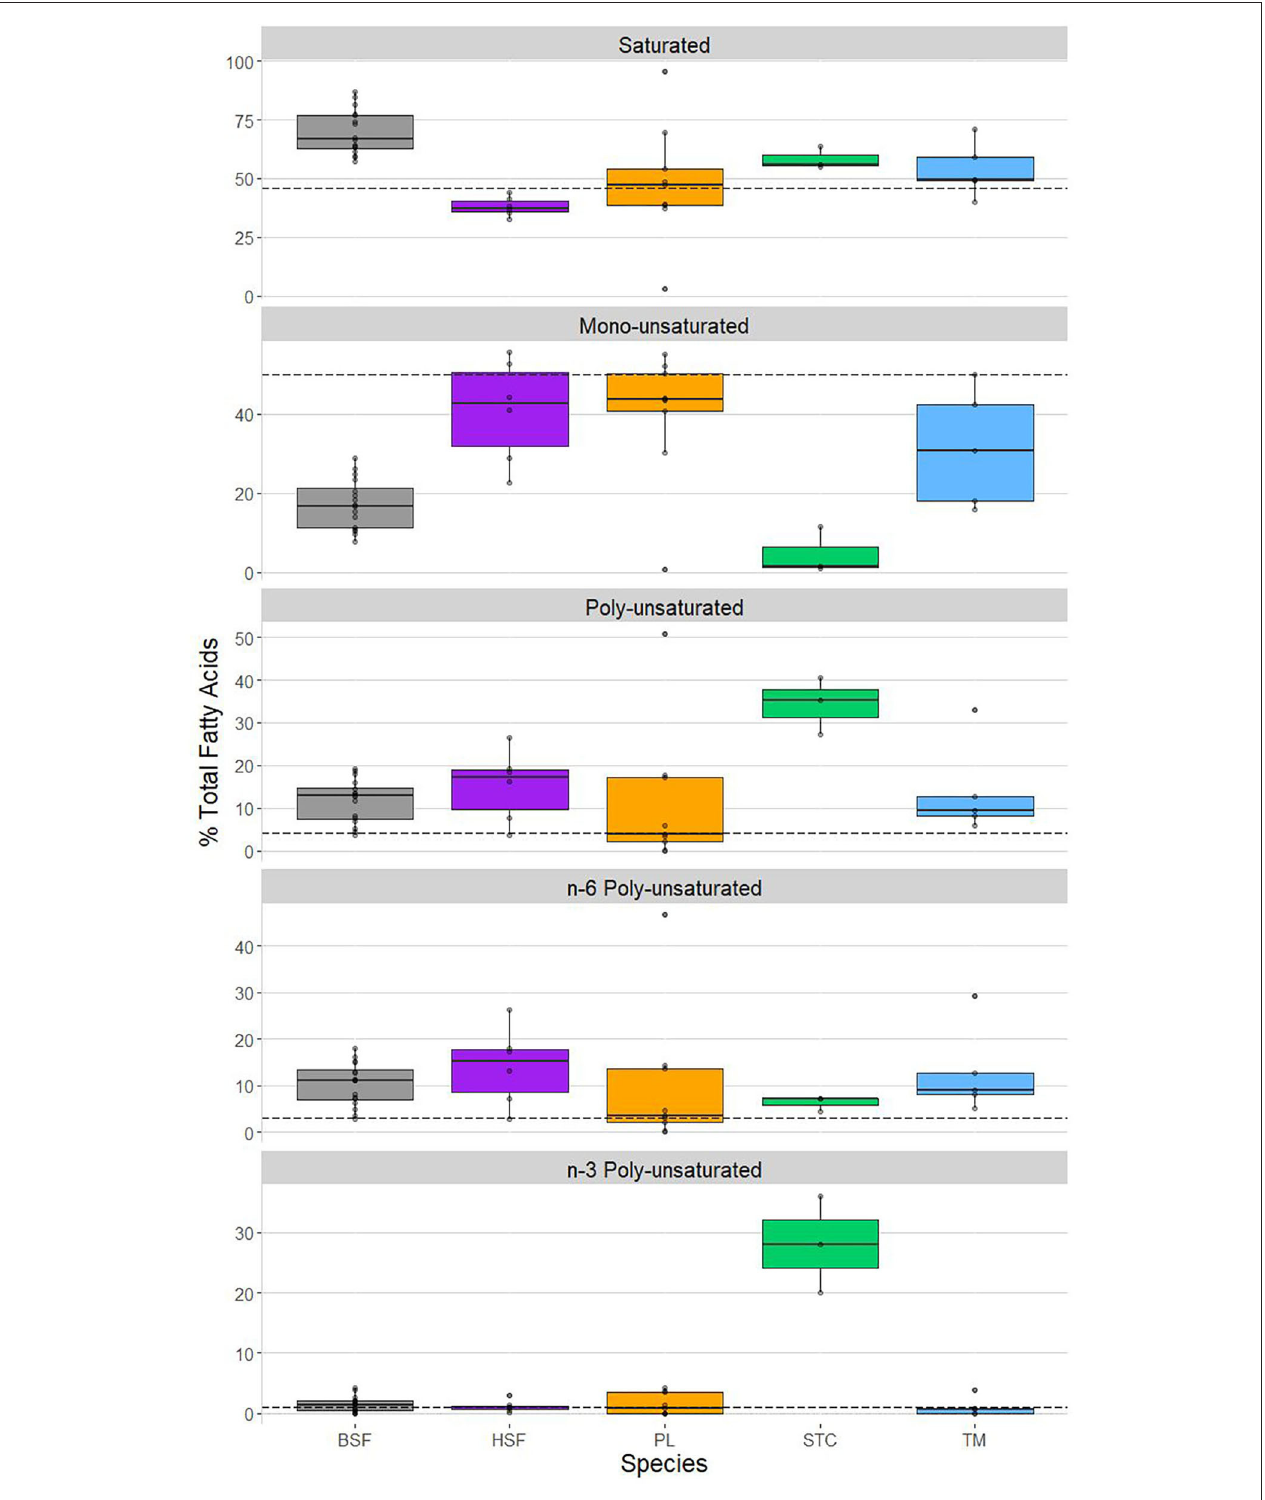
FIGURE 3 | Variation in fatty acid profile saturation as a function of insect species. Shown are each species’ content, as a % of total fatty acids, of, from top to bottom, saturated fatty acids, mono-unsaturated fatty acids, poly-unsaturated fatty acids, n-6 poly-unsaturated fatty acids, and n-3 poly-unsaturated fatty acids. Shown, from left to right, in each panel: Hermetia illucens (black soldier fly, BSF; in gray), Musca domestica (house fly, HSF; in purple), Rhynchophorus phoenicis (palm weevil, PL; in orange), Cirina butyrospermi (shea tree caterpillar, STC; in green), and Macrotermes bellicosus (termite, TM; in blue). The hashed horizontal lines in each panel represent the degree of saturation of the fatty acid profile of beef, obtained from van Huis et al. (24).